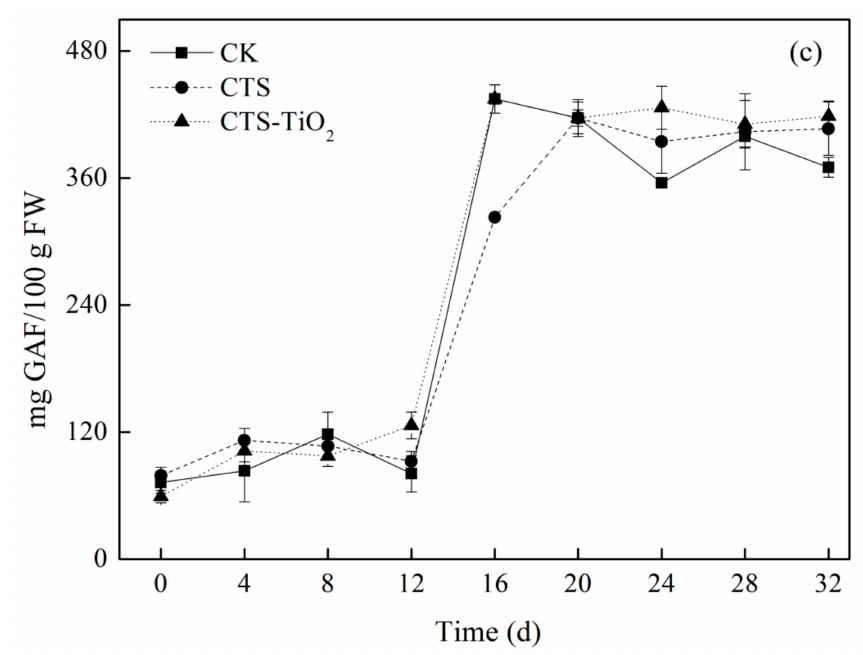
Figure 4. Effects of different treatments on contents of athocyanin ( a ), flavonoid ( b ), and total phenolics ( c ) in pericarp of blueberry fruit during 32 days of storage at 0 ◦